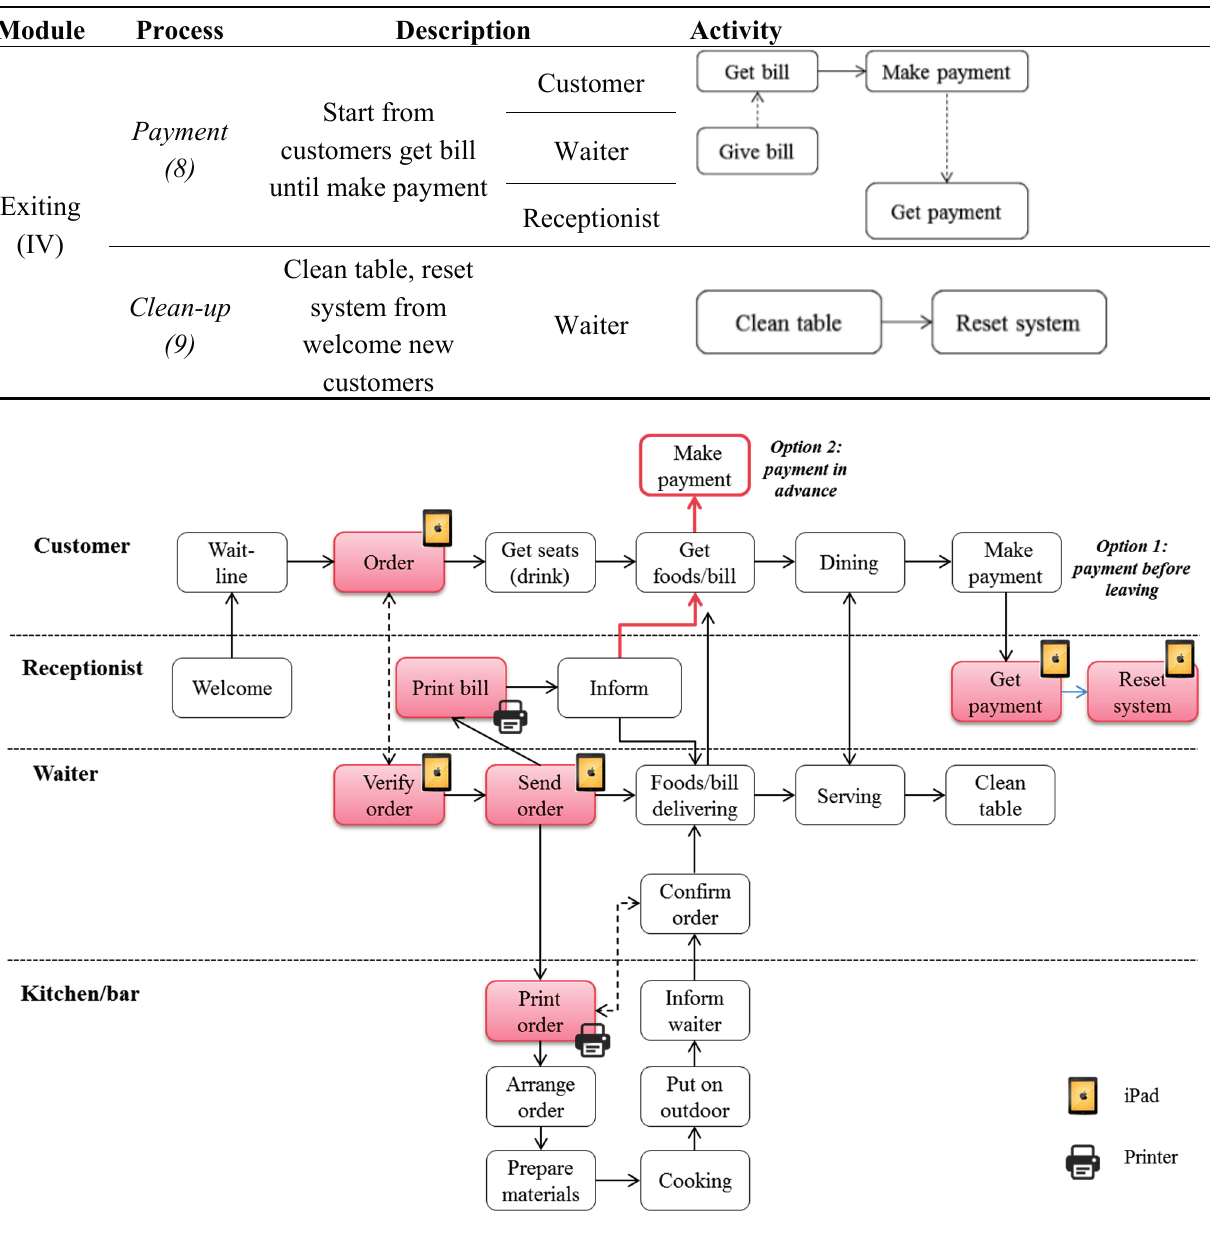
Figure 5. The new